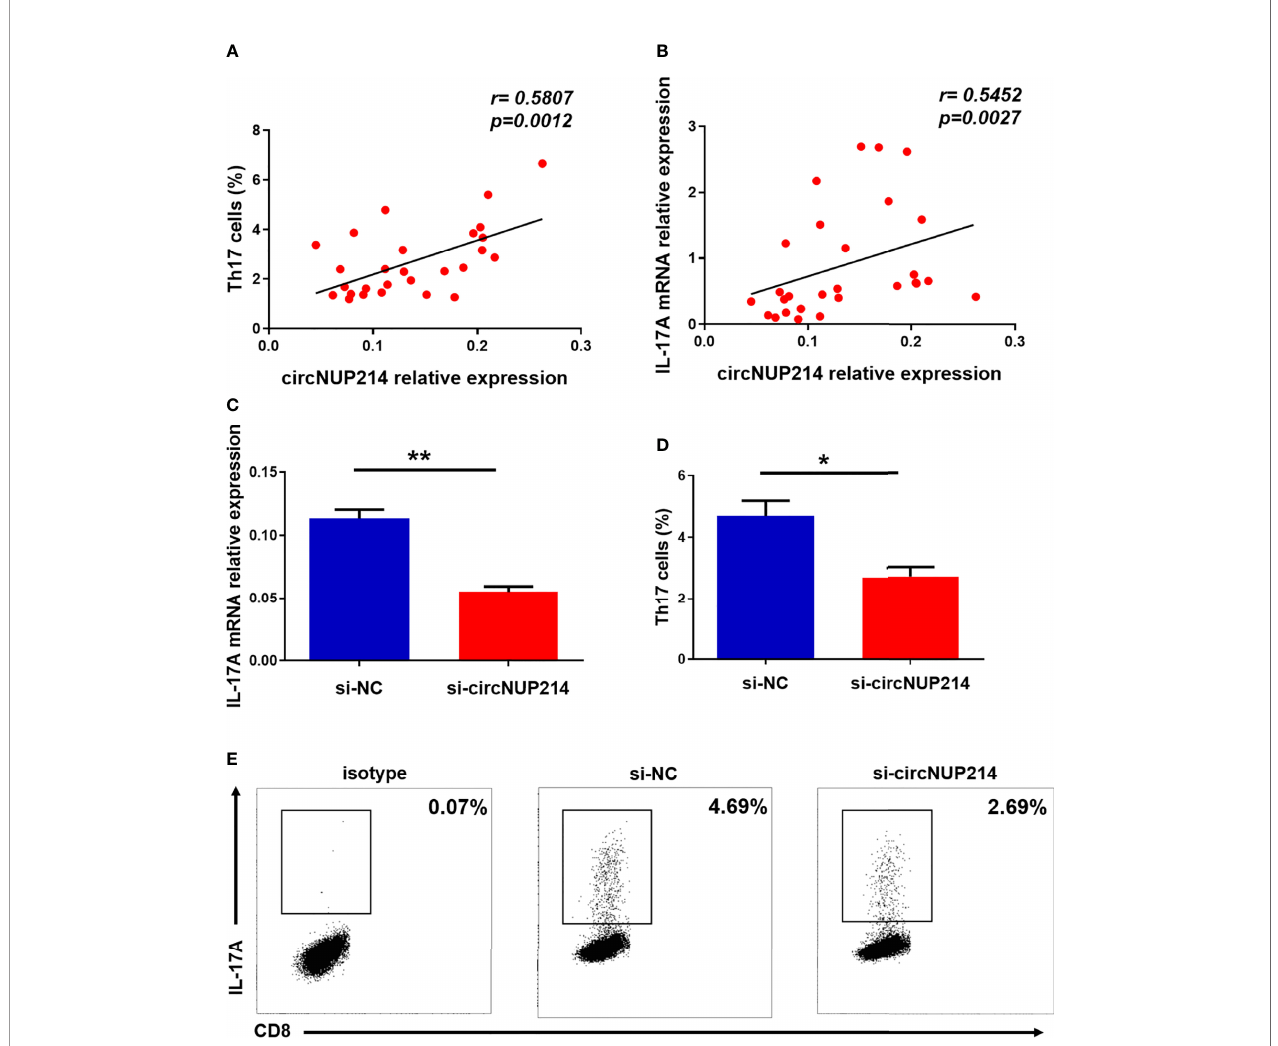
FIGURE 5 | In fl uence of circNUP214 on Th17 cells in RA patients. (A) The correlation between the transcript levels of circNUP214 and the proportion of Th17 cells in 28 RA patients. (B) The correlation between the transcript levels of circNUP214 and the transcript levels of IL-17A in 28 RA patients. Each data point represents an individual subject. Human CD4 + T cells were puri fi ed from PBMCs by magnetic beads and transfected with circNUP214-speci fi c siRNA and NC (100 nM) in the presence of functional anti-human CD3 mAb and anti-human CD28 mAb for 24 h to detect the transcript levels of IL-17A and 48 h before restimulation to determine the proportion of Th17 cells. (C) The relative expression of IL-17A was detected after transfection with circNUP214 siRNA and si-NC. (D, E) The percentage of Th17 cells was analysed by fl ow cytometry. Data represent mean ± S.D. from three independent experiments. * p < 0.05; ** p <